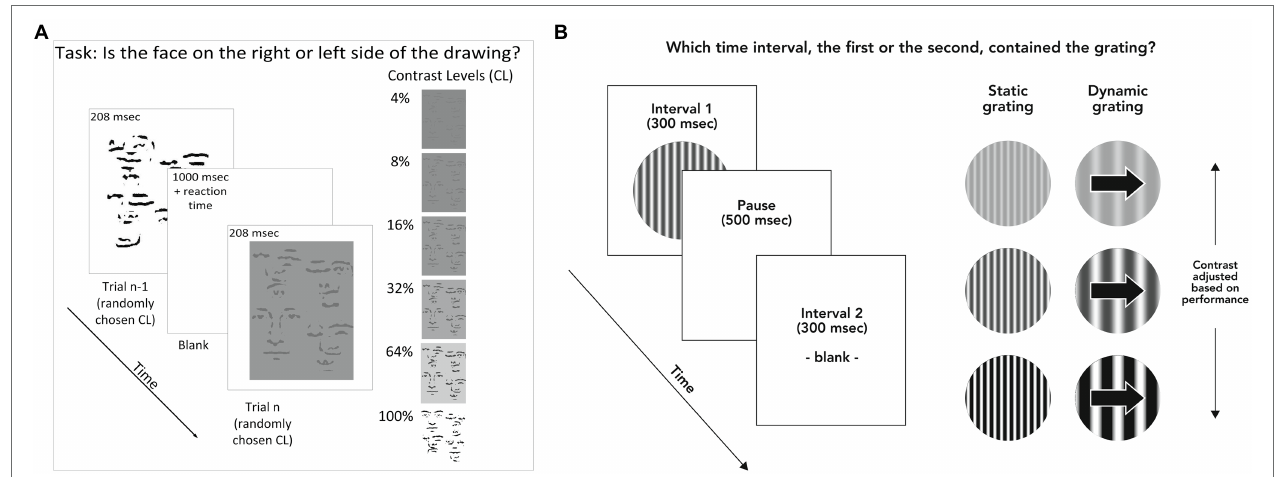
FIGURE 1 | (A) Stimulus and task for face discrimination. Stimulus duration was 208 msec, with a pause of 1,000 msec between each trial to ensure participants had time to fixate. Participants responded by pressing arrow keys to indicate whether the face was on the left or right side of the stimulus. Stimuli were displayed at randomly varying contrast levels of 4, 8, 16, 32, 64, and 100% contrast. (B) Task and stimuli for contrast detection. Subjects indicated which of two time intervals (300 msec each) contained the stimulus (randomly determined each trial). In this example, the grating is shown in the first time interval. Each interval was accompanied by an auditory tone. Participants indicated whether the grating was presented during the first or second time interval by pressing the “1” or “2” key on a computer keyboard. Contrast levels during the task were adjusted according to performance on previous